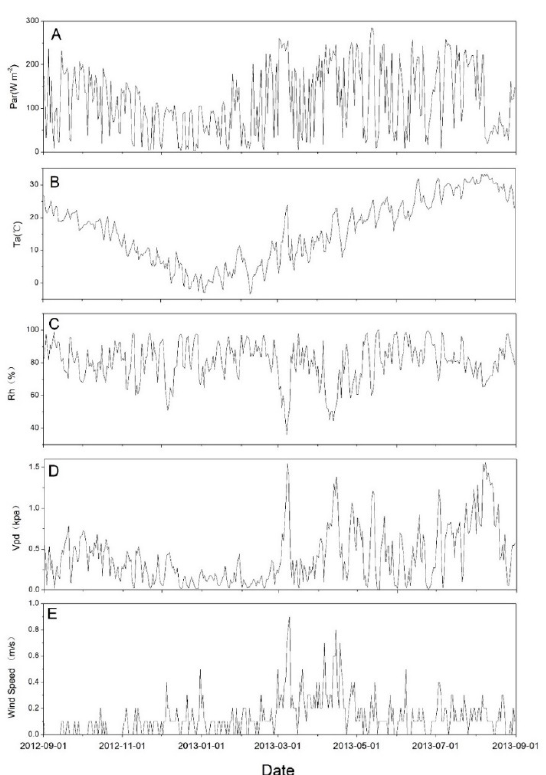
Figure A1. Seasonal course of daily mean photosynthetically-active radiation. (P ar ) ( A ), daily mean air temperature (T a ) ( B ), mean air relative humidity (R h ) ( C ), mean vapor pressure deficit (V pd ) ( D ), mean wind speed ( E ) between 9 September 2012 and 8 August 2013.